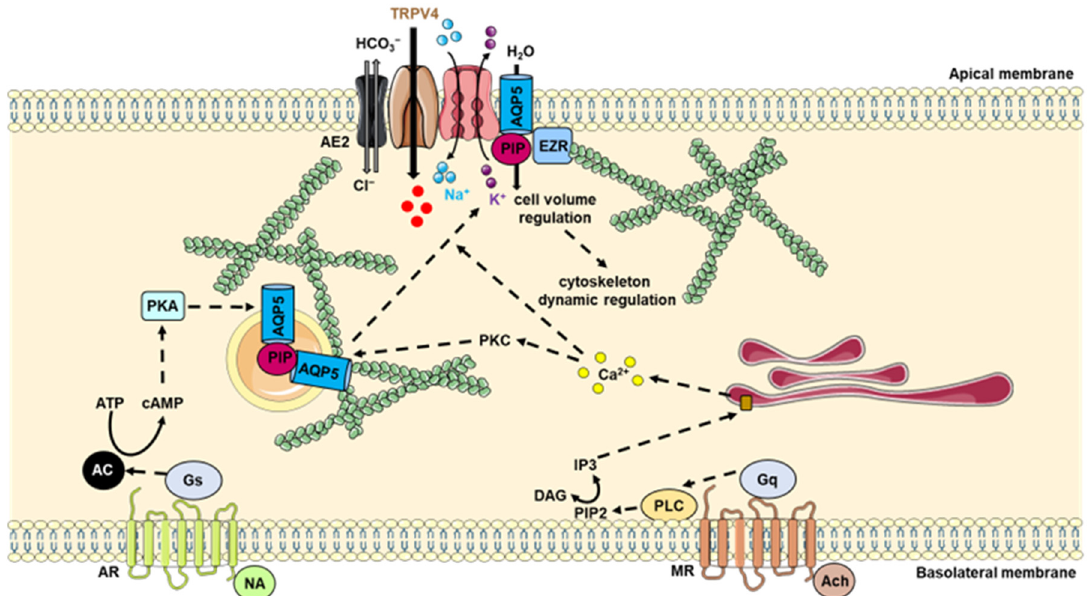
Figure 7. Role of the protein–protein interaction involving AQP5 in salivary gland epithelial cells. Nervous stimulation induces the release of both NA and Ach, which bind to AR and MR. AR activation induces the subsequent activation of Gs protein and AC. AC induces an increase in intracellular levels of cAMP, which activates PKA. MR activation induces the subsequent activation of protein Gq and PLC. PLC cleaves PIP2 into IP3 and DAG. IP3 stimulates calcium release from endoplasmic reticulum and the activation of PKC. These stimuli induce AQP5 trafficking to the plasma membrane. The interaction between AQP5 and NKCC1, AE2 and TRPV4 is likely involved in cell volume regulation and cytoskeleton dynamic regulation, while the interaction between AQP5 and